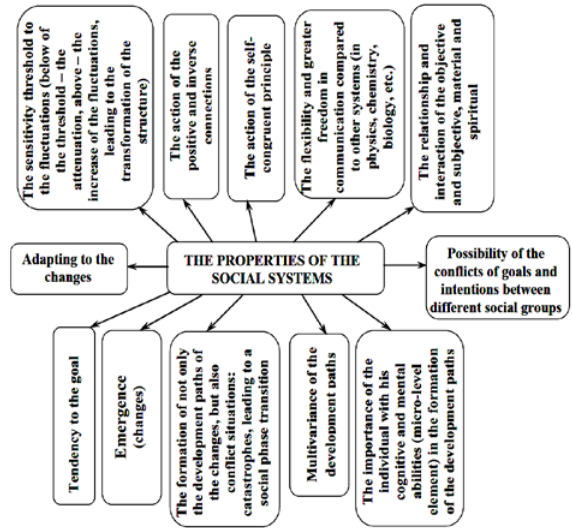
Fig.2. The properties of the social systems. The i nformation d etermines t he o rder p arameters,